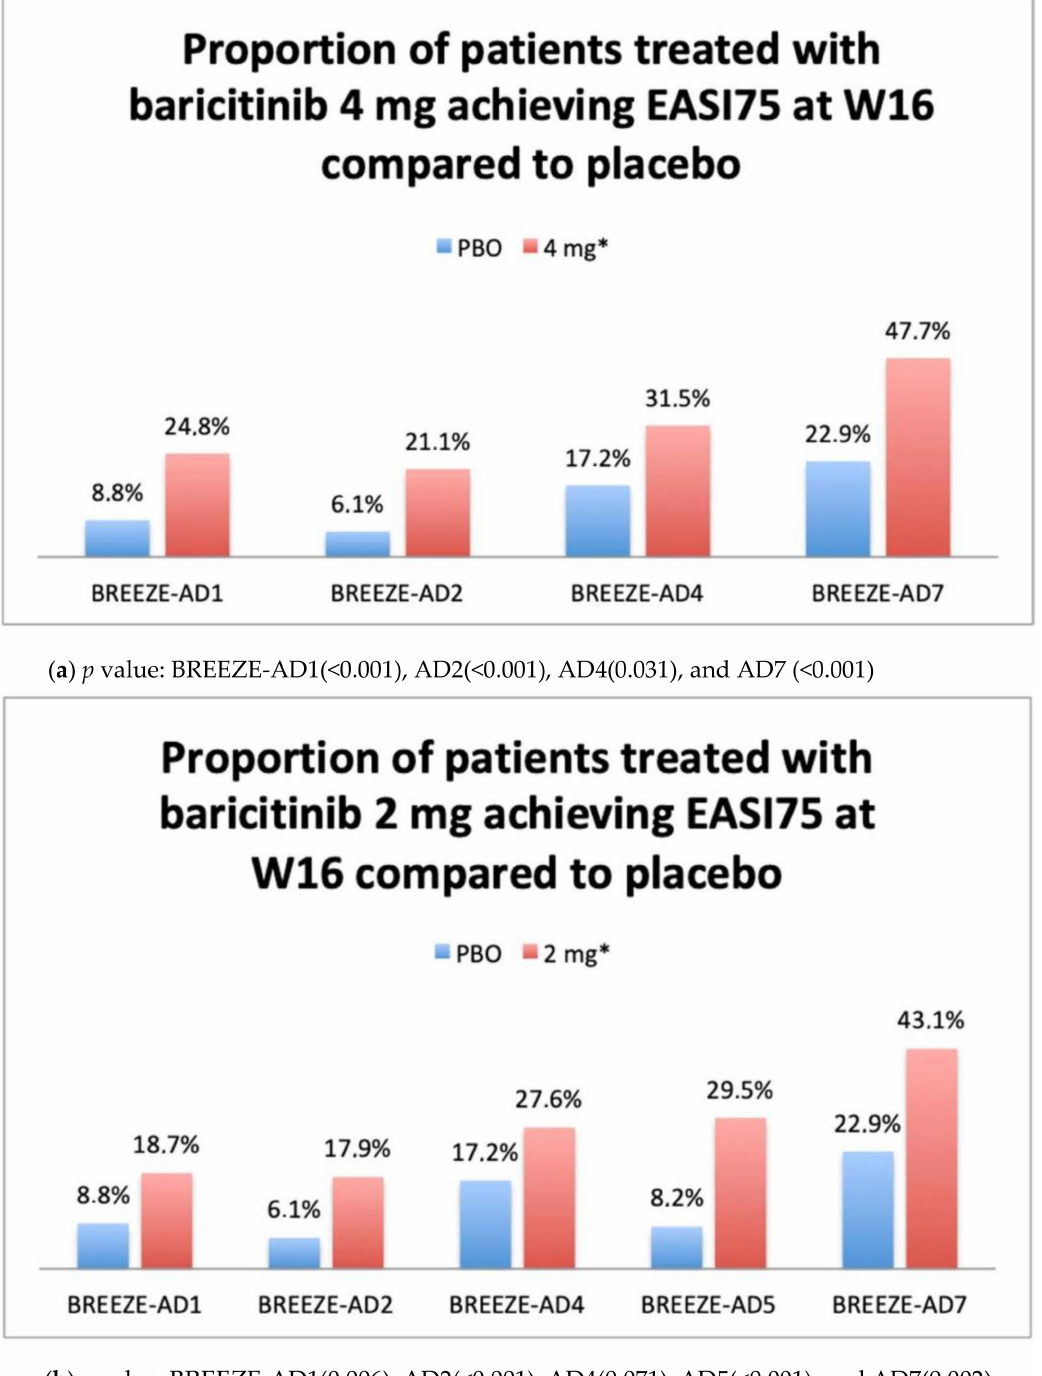
Figure 2. ( a ) Primary efficacy endpoint from BREEZE AD1, AD2, AD4, and AD7: Proportions of patient treated with baricitinib 4 mg achieving EASI75 at W16 compared to placebo. Abbreviations: PBO, placebo; EASI, Eczema Area Severity Index; W16, week 16. * In BREEZE-AD 4 and AD7, baricitinib was administered in association with topical corticosteroid as for protocol. ( b ) Primary efficacy endpoint from BREEZE-AD1, AD2, AD4, AD5, and AD7: Proportions of patient treated with baricitinib 2 mg achieving EASI75 at W16 compared to placebo. Abbreviations: PBO, placebo; EASI, Eczema Area Severity Index; W16, week 16. * In BREEZE-AD 4 and AD7, baricitinib was administered in association with topical corticosteroid as for